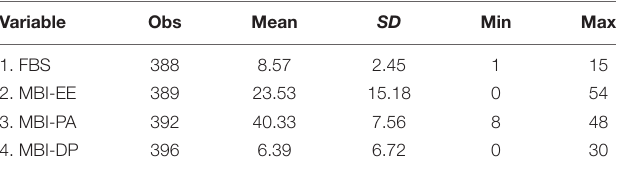
TABLE 2 | Descriptive statistics for fuster-bewat score (FBS), Maslach Burnout Inventory (MBI) emotional exhaustion (MBI-EE), depersonalization (MBI-DP), and personal accomplishment (MBI-PA) subscale scores.